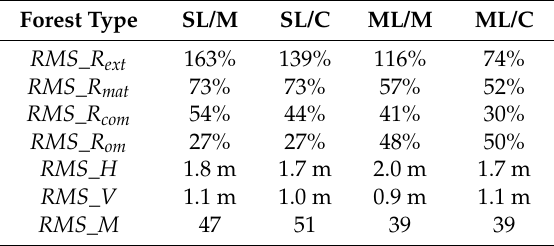
Table 7. Matching results for different forest types. Forest Type SL/M